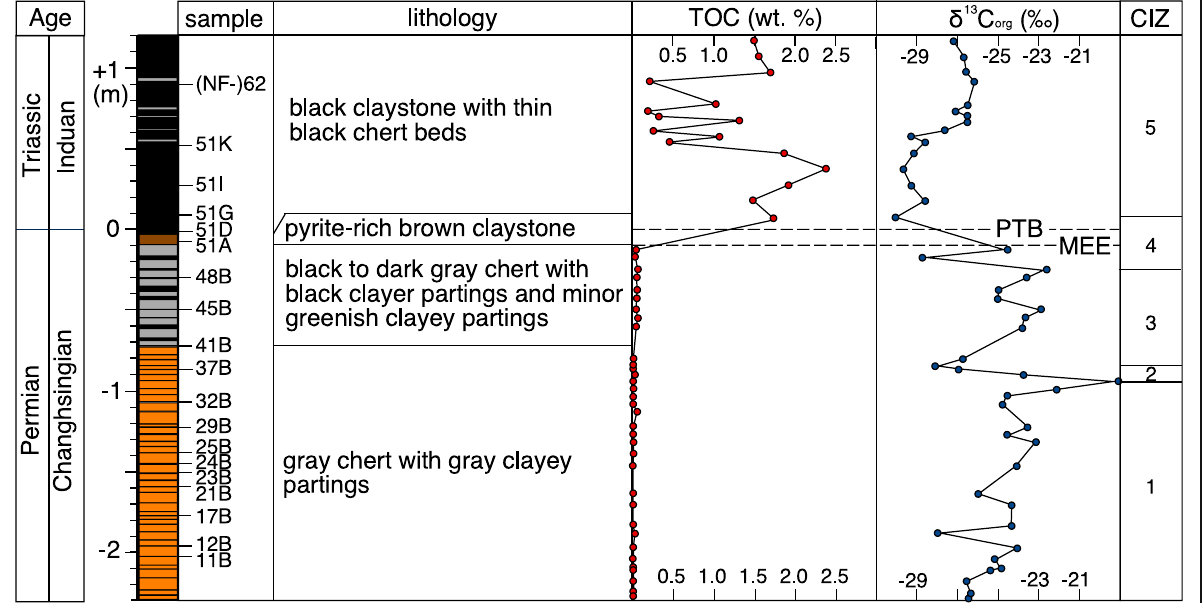
Fig. 1 Lithology and geochemical profiles of the study section. Stratigraphic column showing samples, lithologies, total organic carbon contents (TOC, wt.%), and organic carbon isotopic values ( δ 13 C org , VPDB ‰ , divided into carbon isotope zones, CIZ). Modified after Sano et al.